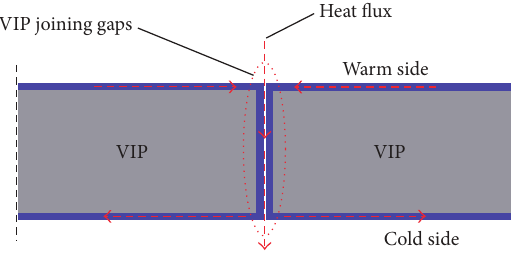
Figure 13: Heat bridge effect surrounding the VIP.